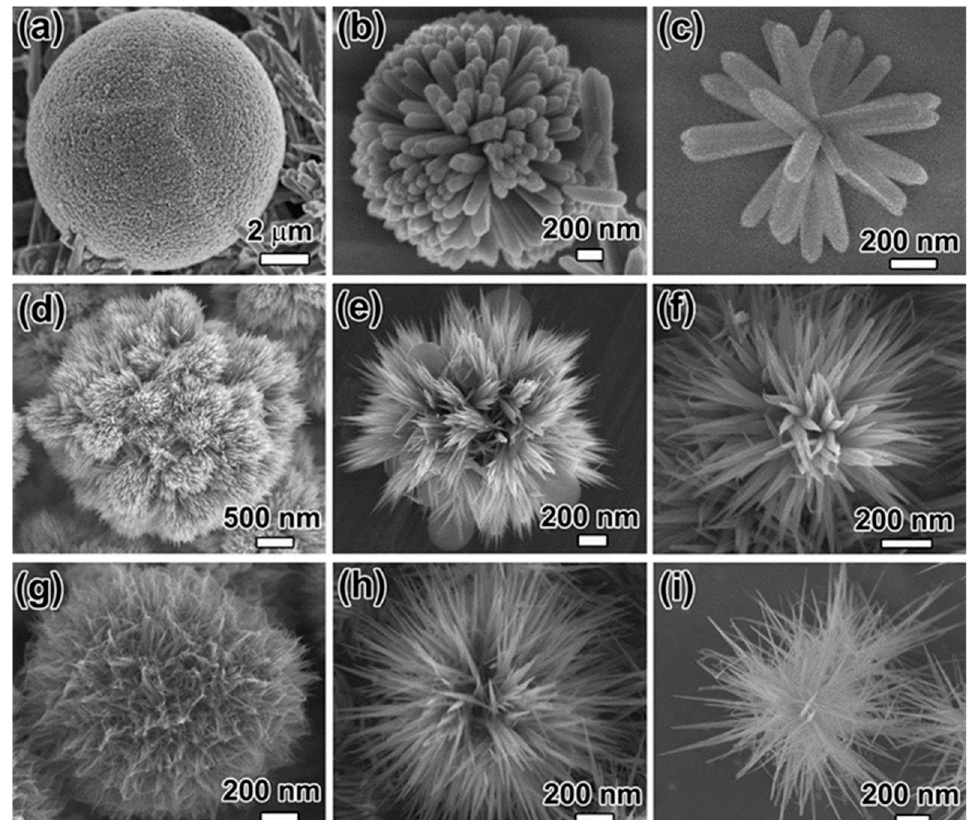
Figure 10. SEM images of 3D dendritic TiO 2 nanostructures: ( a – c ) 3D TiO 2 microspheres with nanorod building units obtained from aqueous titanium isopropoxide (TTIP) solutions having the composition of ( a ) 100H 2 O:7HCl:0.03CTAB:0.05TTIP, ( b ) 100H 2 O:7HCl:0.03CTAB:0.03TTIP, and ( c )